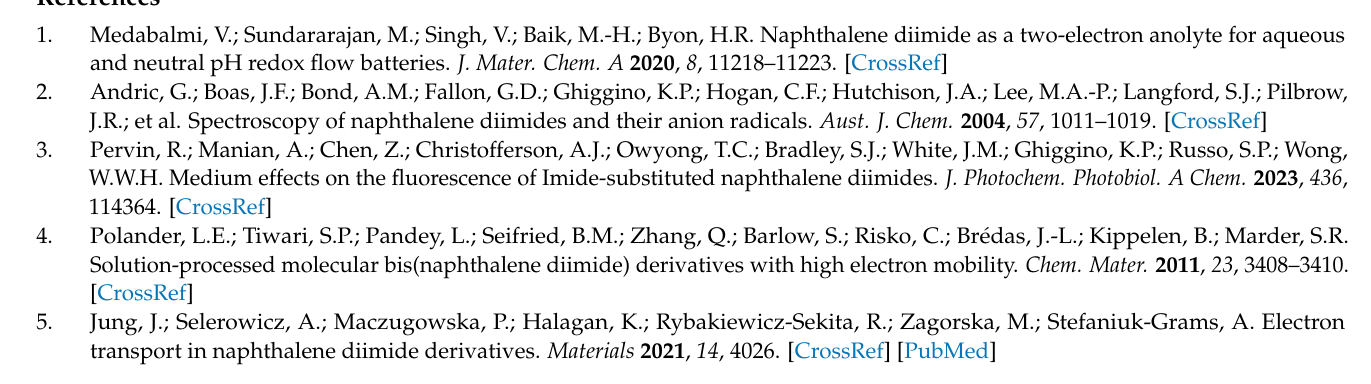
Figure S3: Unit cells of NDIC6 and NDIC7; Figure S4: Exemplary one-dimensional I(q) profiles of NDIC6: simulated in Mercury software and experimental; Figure S5: TGA curves of NDIs; Figure S6: DSC plots for the 1st heating and 1st cooling cycles, and 2nd heating cycle of NDIs; Figure S7: Exemplary output current–voltage characteristics for NDC7